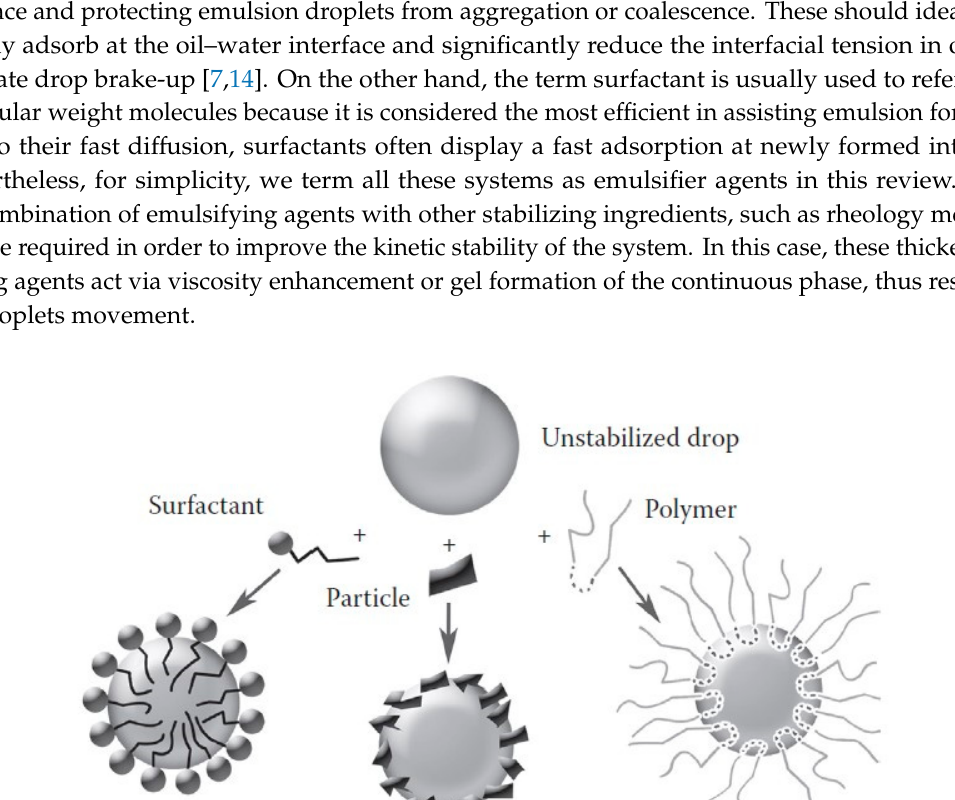
Figure 1. Breakdown mechanisms of an emulsion. Note that different processes may occur simultaneously. Adapted with permission from [13]. Copyright John Wiley and Sons.